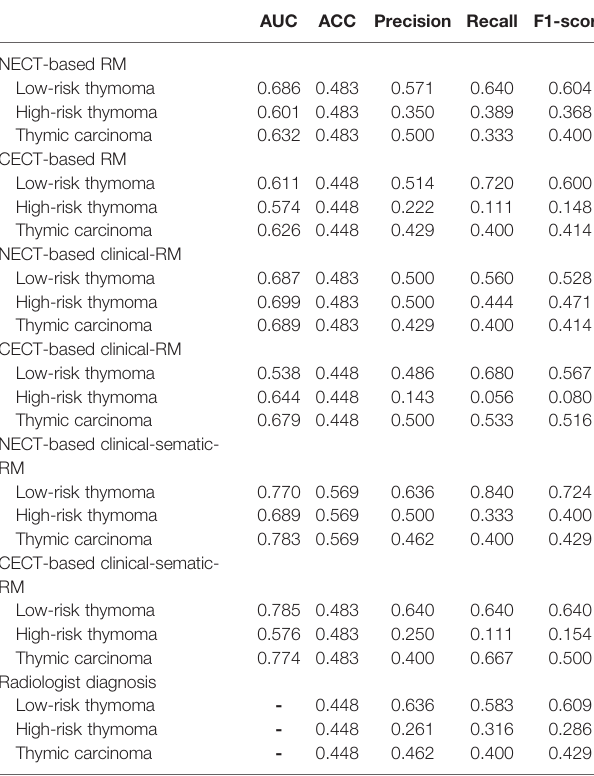
TABLE 2 | Performance of three-class models in training set. TABLE 3 | Performance of three-class models in validation